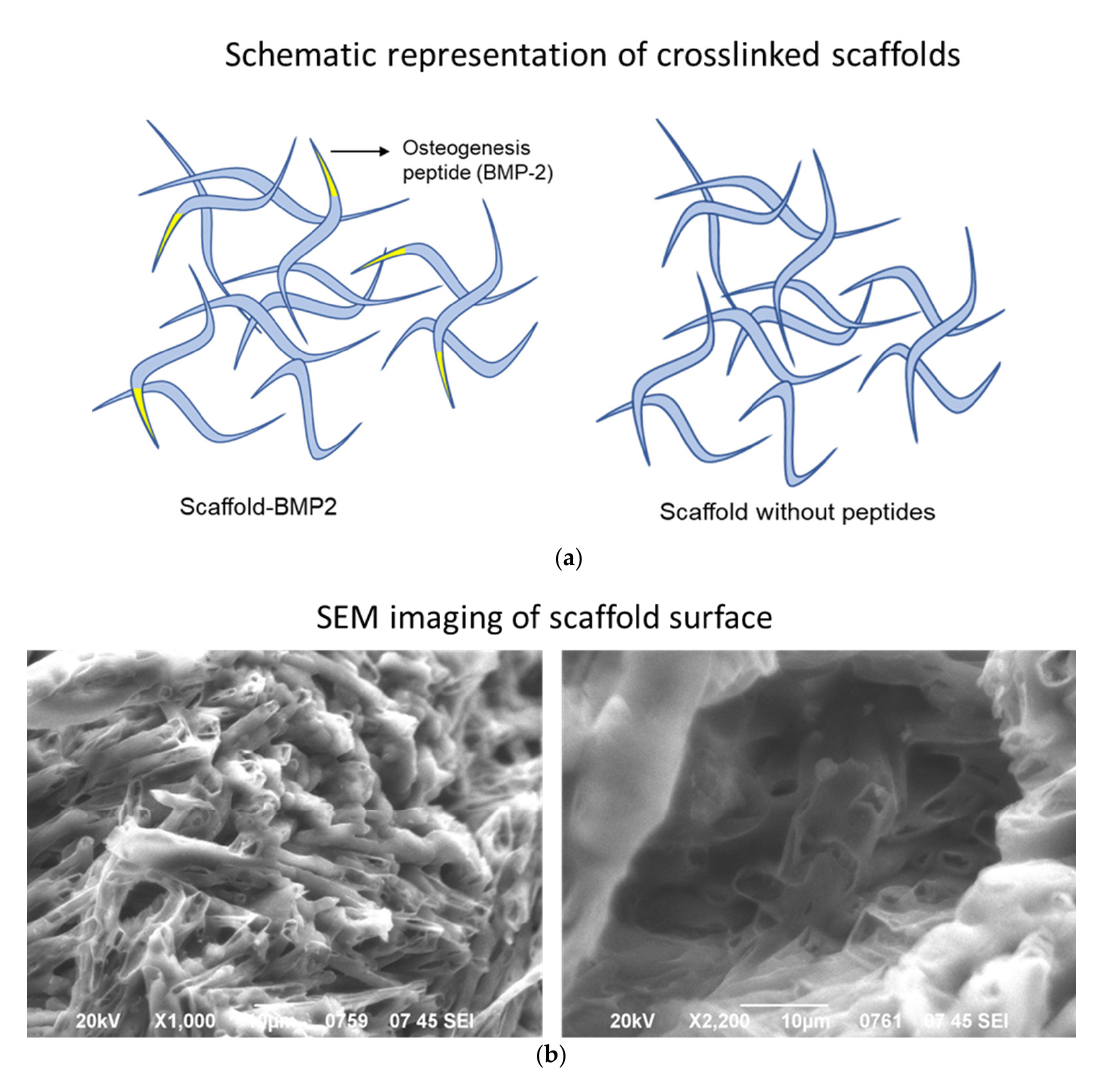
surface (~50 µ m pore size) with high interconnectivity. Table 2. Composition of crosslinked scaffolds. Polypeptides Scaffold without Peptides